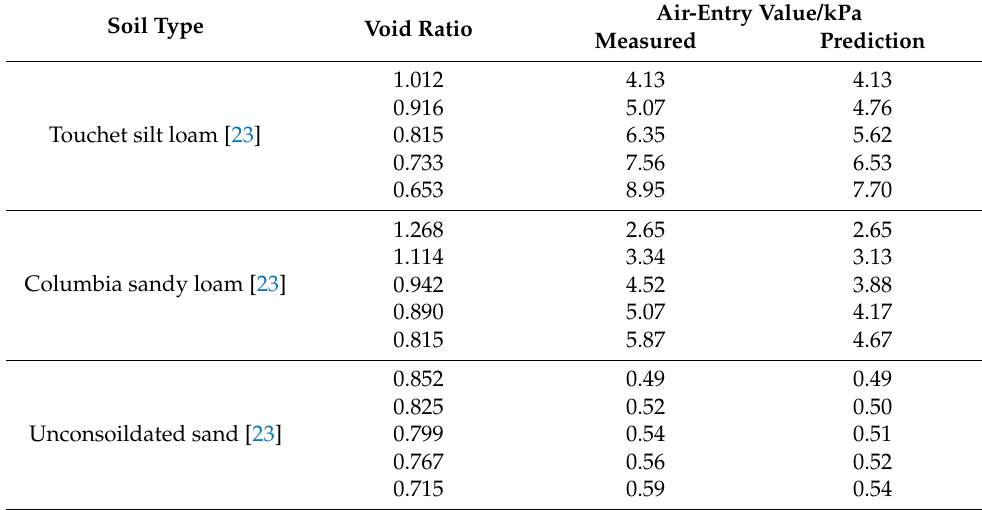
Table 2. Air-entry value predicted